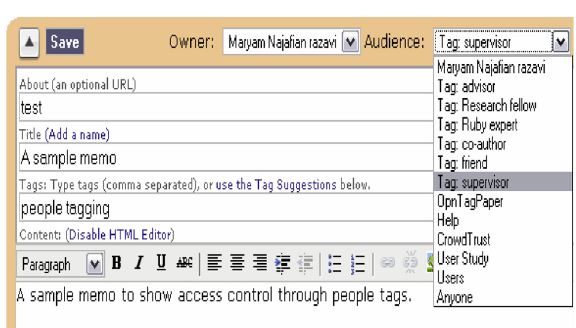
Figure 7. Selective sharing of a memo in OpnTag, with both classic and egocentric